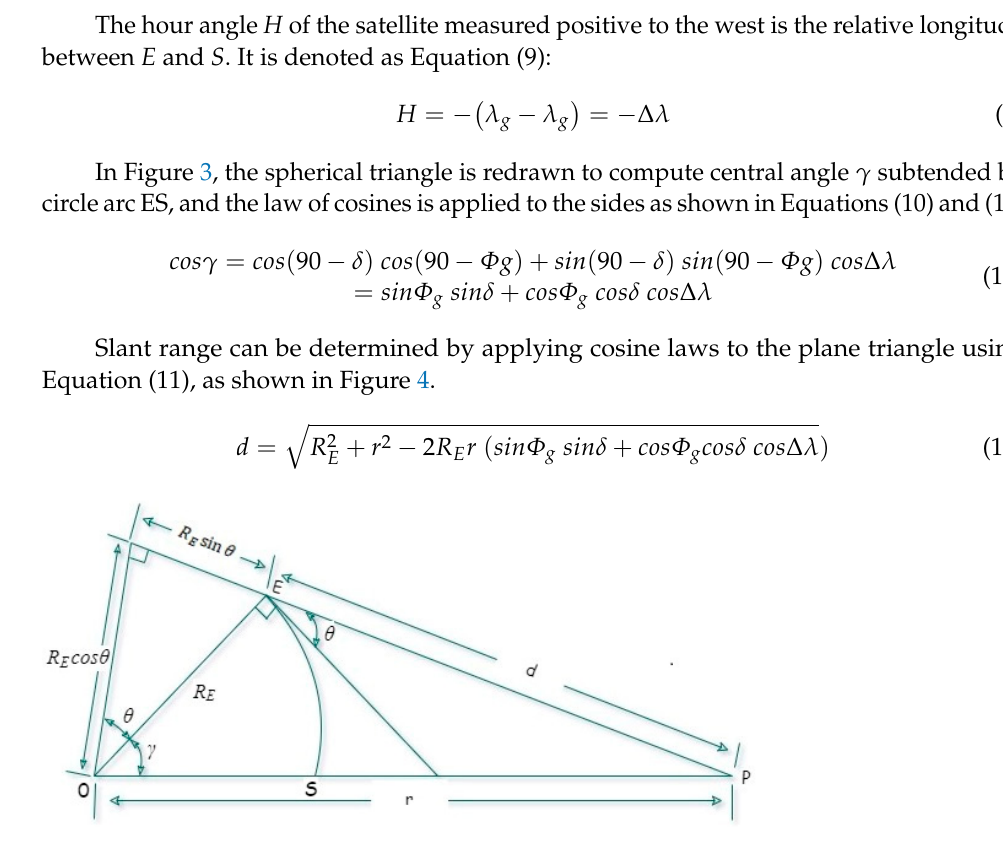
Figure 4. Slant range angle geometrical representation.